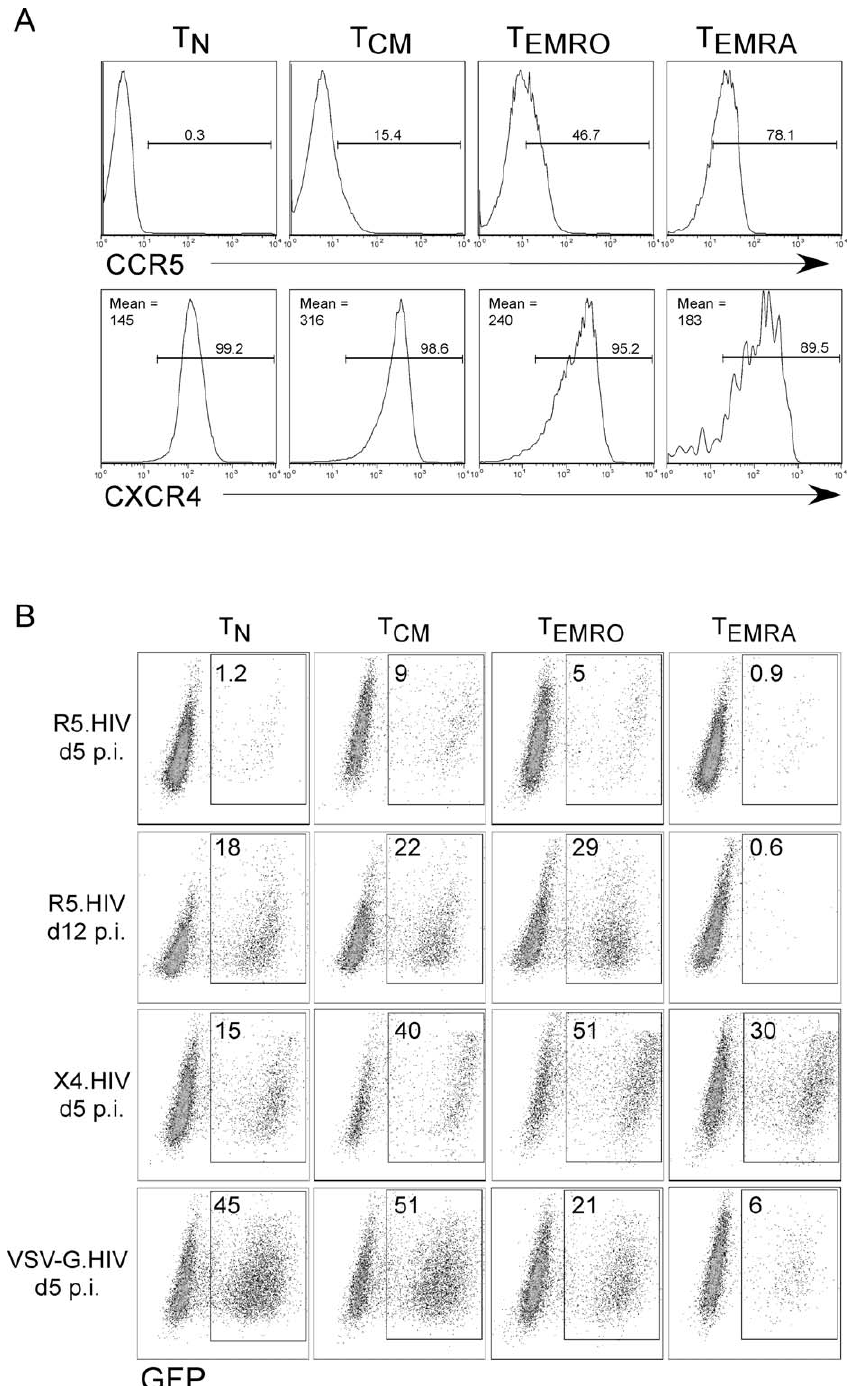
Figure 4. Expression of HIV-1 Coreceptors on CD4 þ T Cell Subsets and Their Susceptibility to HIV-1 Infection (A) CD4 þ T cells from an HIV-uninfected individual were stained with CD45RO-PE and CCR7-FITC in conjunction with CCR5 and CXCR4 antibodies. CD4 þ T cell subsets were gated as described in Figure 1, and expression of CCR5 and CXCR4 was analyzed. (B) Purified CD4 þ T cell subsets from an HIV-uninfected individual were activated using plate-bound anti-CD3 (3 l g/ml) and soluble anti-CD28 (1 l g/ml) antibodies and concurrently infected with VSV-G.HIV, R5.HIV, or X4.HIV. Percent infected cells was determined by GFP expression of T cells on day 5 and 12 post-infection (p.i.). The results are representative of one of five independent experiments using T cell subsets isolated from five different individuals. The median infection values at day 5 were: R5-HIV: T N ¼ 1.1, T CM ¼ 9.5, T EMRO ¼ 5.4, and T EMRA ¼ 0.85; X4-HIV: T N ¼ 17, T CM ¼ 36, T EMRO ¼ 43, and T EMRA ¼ 33; and VSV-G.HIV: T N ¼ 44, T CM ¼ 48, T EMRO ¼ 19, and T EMRA ¼ 6.5.